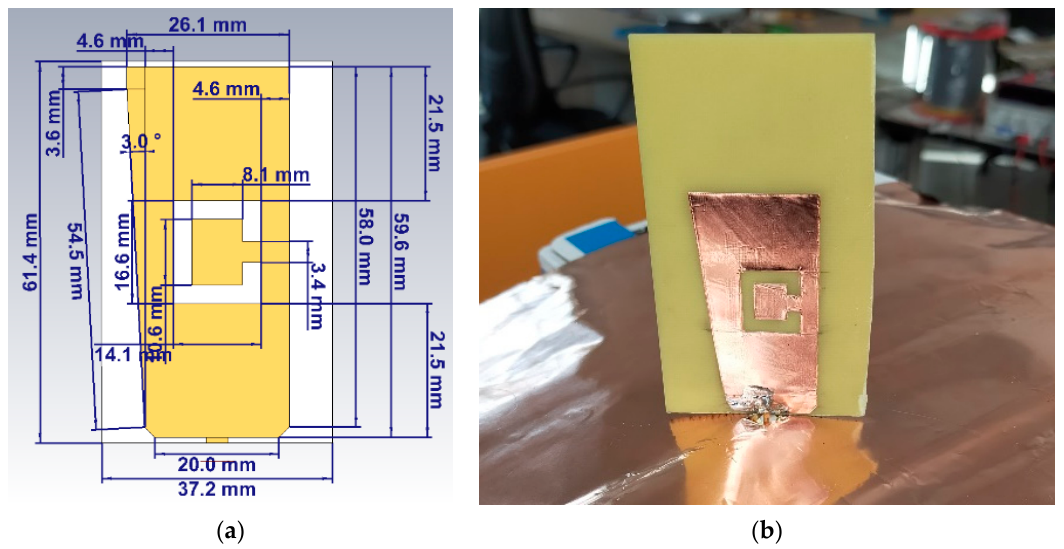
Figure 21. Side view of the blade antenna in FR-4 material, ( a ) 3D model with final dimensions (XZ side view) and ( b ) actual prototype (XZ side view). It is possible to see both the blade-shaped monopole on FR-4 substrate and the ground plane sheet made of thin copper.